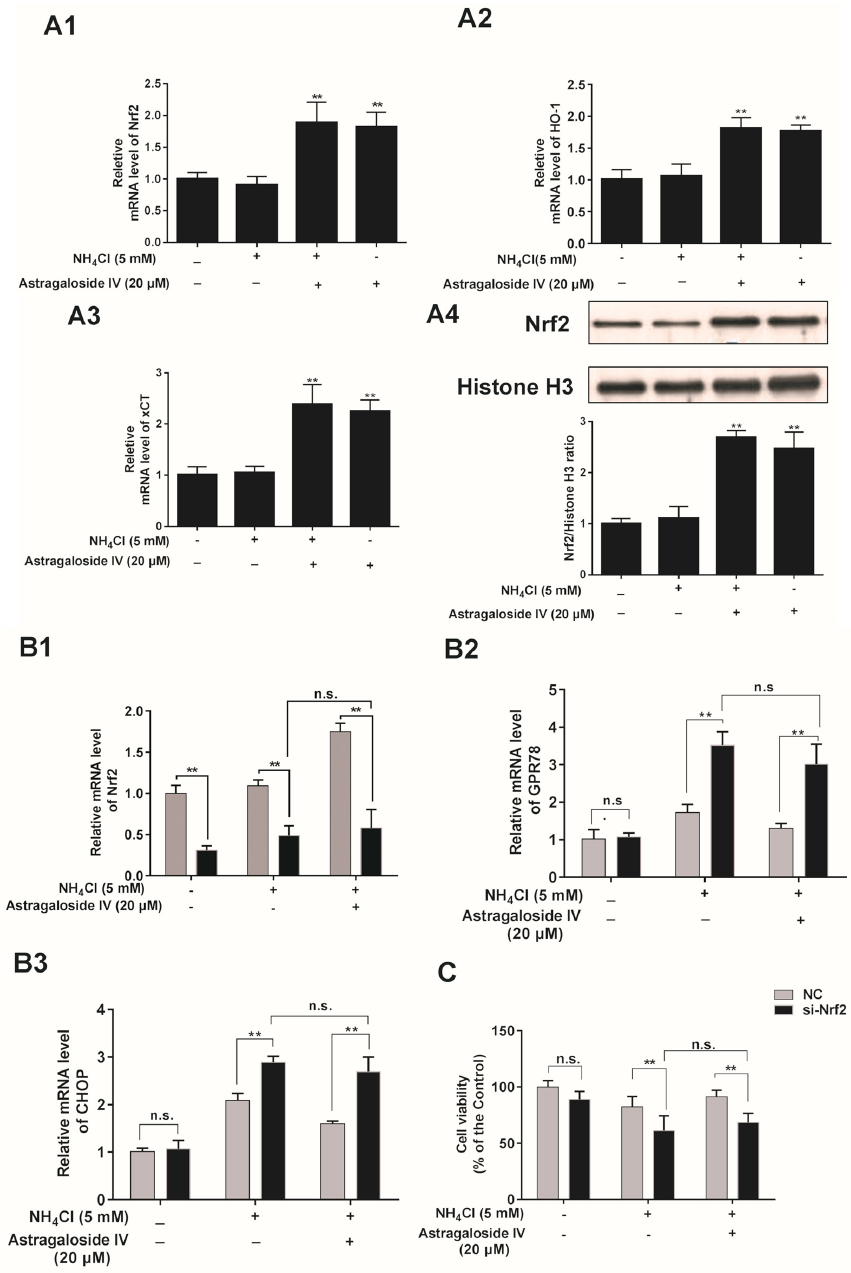
Figure 6. Astragaloside IV protects MAC-T cells against ammonia-induced oxidative stress by the activation of Nrf2. ( A ) Quantitative real-time PCR analysis of Nrf2 ( A1 ), HO-1 ( A2 ), and xCT ( A3 ) mRNA in MAC-T cells pretreated with or without astragaloside IV for 4h and then treated with or without NH 4 Cl for 24 h. The nuclear protein level of Nrf2 ( A4 ) was analyzed by Western blotting. Relative protein levels were analyzed by grey scanning. The data are shown as means ±SD, n = 3; **, p < 0.01. ( B ) The mRNA expressions of Nrf2( B1 ), GRP78( B2 ) and CHOP( B3 ) in MAC-T cells transfected with either an Nrf2 siRNA (Si-Nrf2-3) or a control siRNA (NC) for 16 h and pretreated with astragaloside IV for 4 h followed by NH 4 Cl treatment for an additional 24 h. ( C ) Cell viability assay in MAC-T cells transfected with either an Nrf2 siRNA or a control siRNA (NC) for 16 h and with or without astragaloside IV pretreatment for 4h followed by NH 4 Cl treatment for additional 24 h. The data are shown as mean ± SD. n = 6. **, p < 0.01. n.s. indicates no significance.